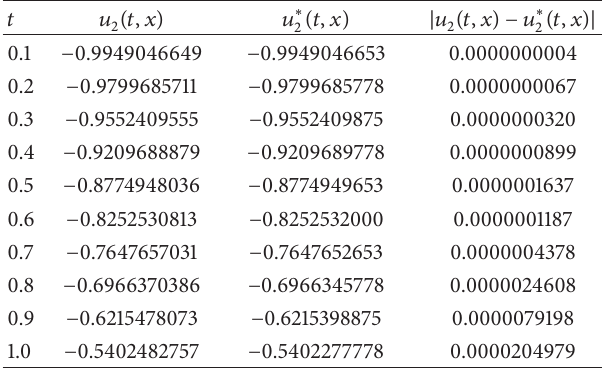
Table 2: The numerical and exact solution of the test problem(32), where 𝑢 2 (𝑡,𝑥) is exact solution and 𝑢 ∗ 2 (𝑡,𝑥) is numerical solution, for 𝑥 = 0.1